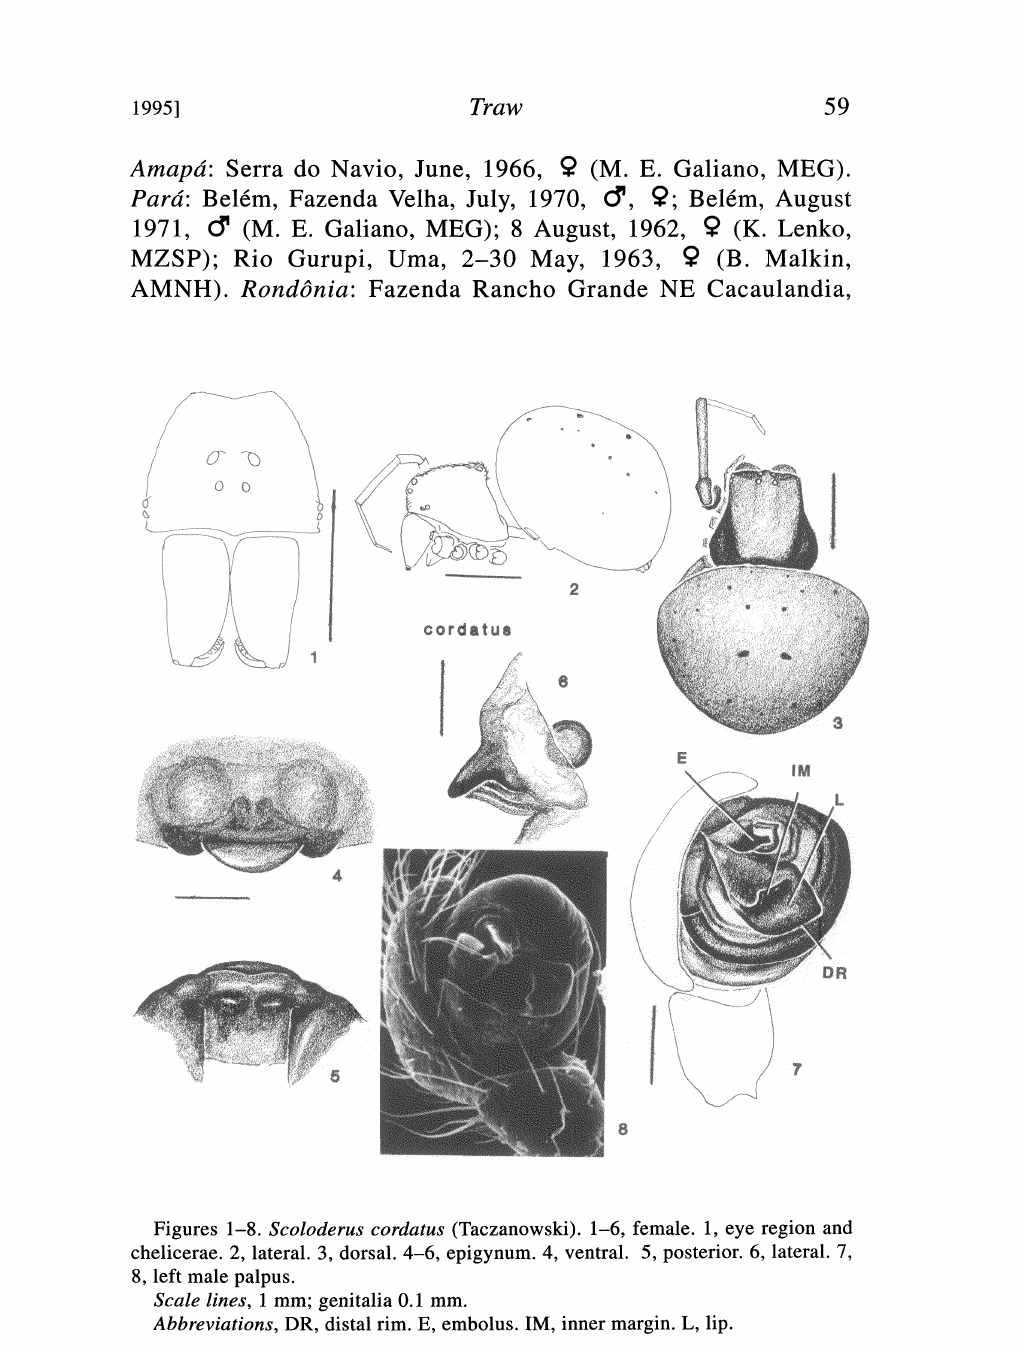
Figures 1-8. Scoloderus cordatus (Taczanowski). 1-6, female. 1, eye region and chelicerae. 2, lateral. 3, dorsal. 4-6, epigynum. 4, ventral. 5, posterior. 6, lateral. 7, 8, left male palpus. Scale lines, mm; genitalia 0.1 mm. Abbreviations, DR, distal rim. E, embolus. IM, inner margin. L,